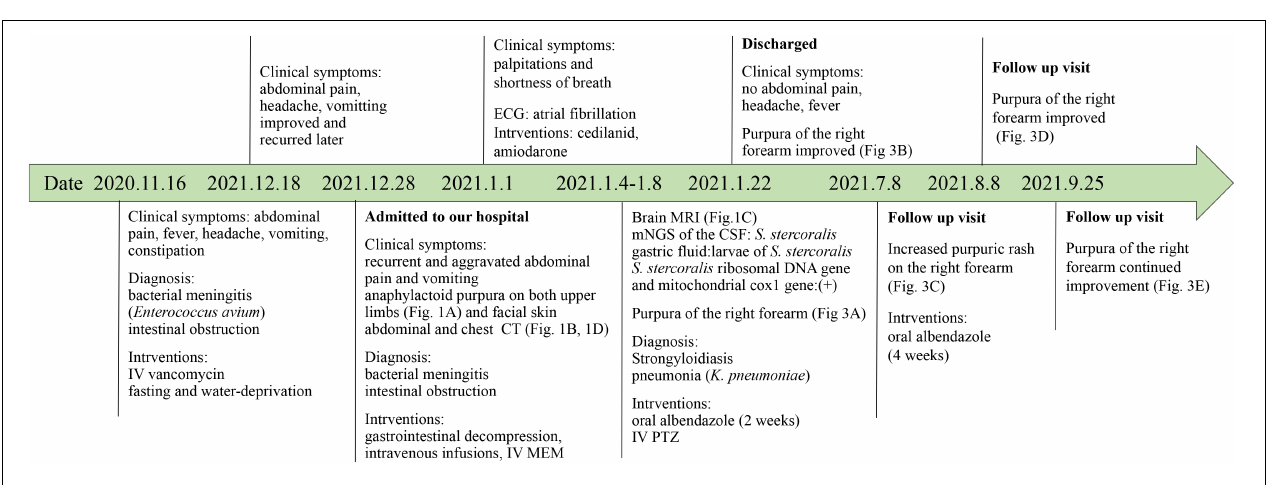
FIGURE 4 | Timeline of the patient with relevant data of the past episodes and interventions. CSF, Cerebrospinal fluid; CT, computer tomography; IV, intravenous; MEM, meropenem; mNGS, metagenomic next-generation sequencing; MRI, magnetic resonance imaging; PTZ, piperacillin